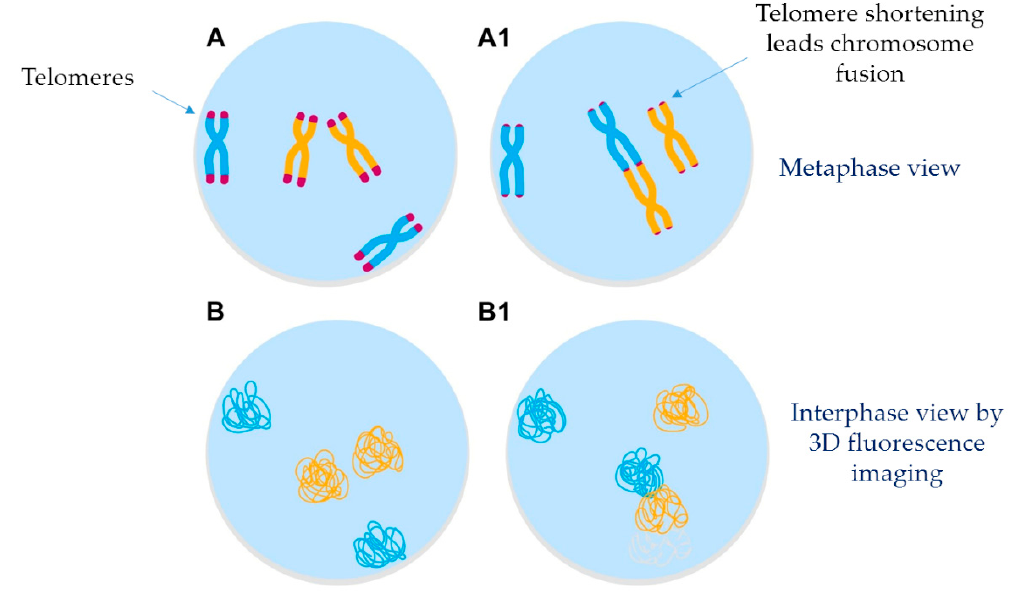
Figure 2. Model of chromosome reorganization in PTC. Changes in chromosome territories can reprogram gene expression. Some chromosomes localize toward the nuclear periphery, often touching the nuclear membrane, whereas others are located towards the center of the nucleus. In PTC, changes in chromosome territories can decrease the distance between genes, leading to a high rate of recurrence of specific chromosome rearrangements or inversions in PTC.